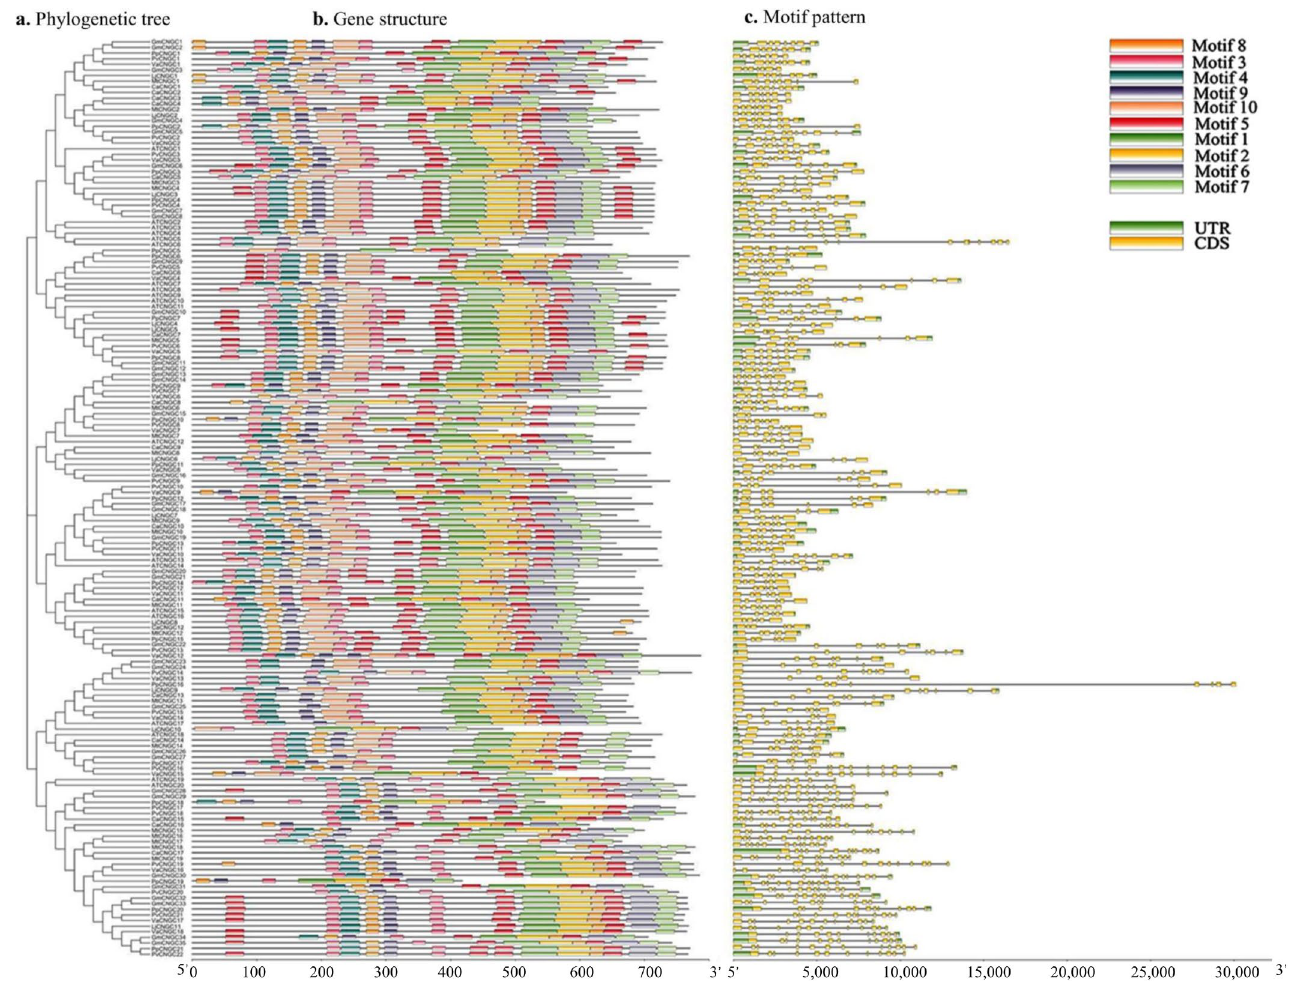
F igure 3. Phylogenetic relationships, gene structure, and architecture of conserved protein motifs in CNGC genes from legumes.